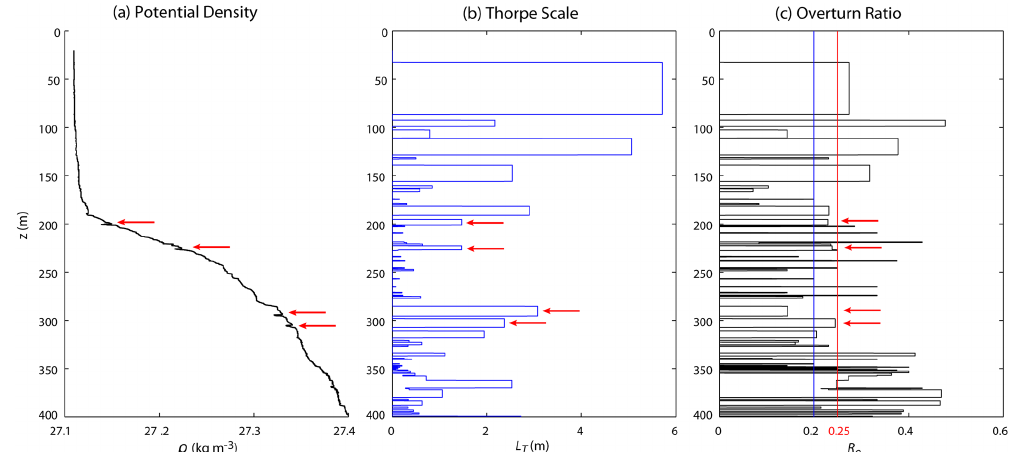
Figure 3. Sample illustration showing the (a) intermediate density profile, (b) Thorpe scales, and (c) overturn ratios calculated at station A3-1. Four suspicious false overturns associated with abnormal spikes clearly apparent in the density profile are indicated by red arrows. Two criteria of overturn validation are shown by colored vertical lines in (c) blue for R o = 0 . 2 and red for R o = 0 . 25.